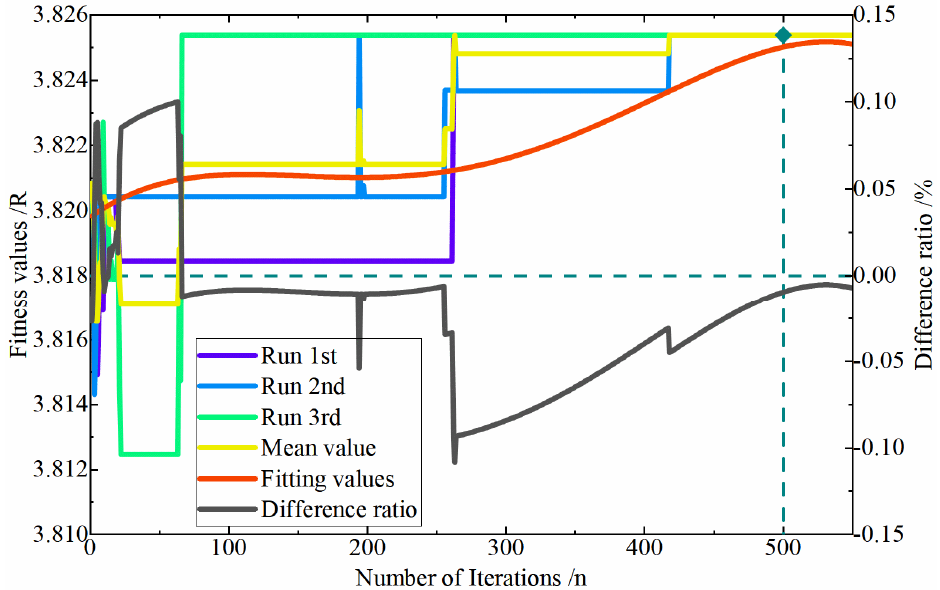
Figure 9. The curve of reliability of the IGA.